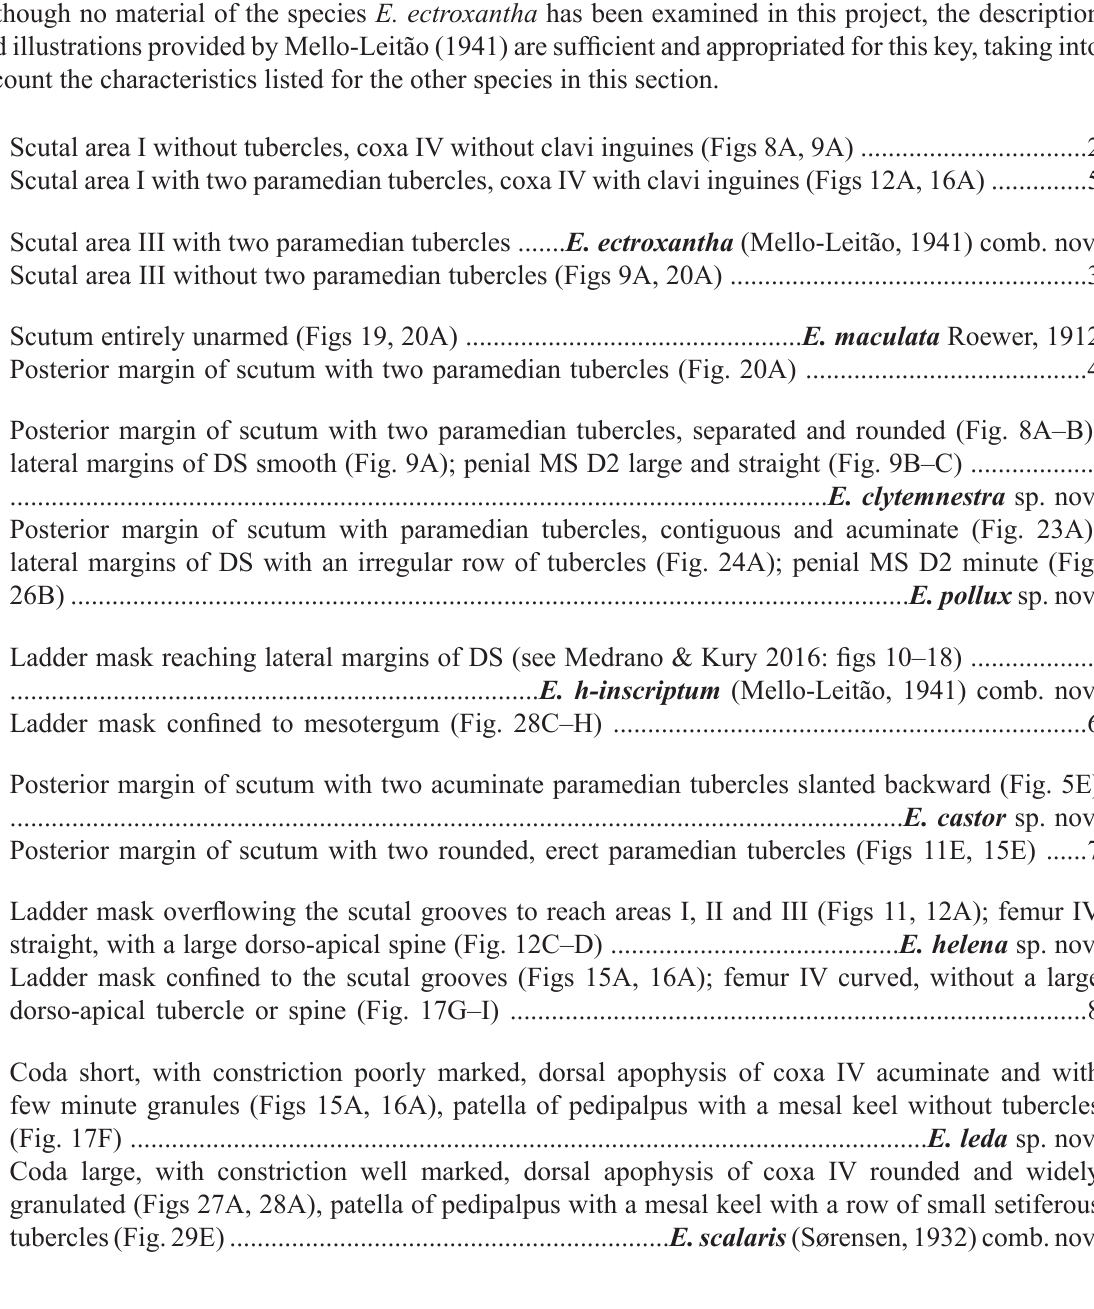
feminine. Brachylibitia : from Greek βραχύς (short) + pre-existing generic name Libitia . Gender feminine. Platymessa : from Greek πλατύ- (flattened) + pre-existing generic name Messa . Gender feminine. Messatana : variation of pre-existing genus Messa . Gender feminine. Included